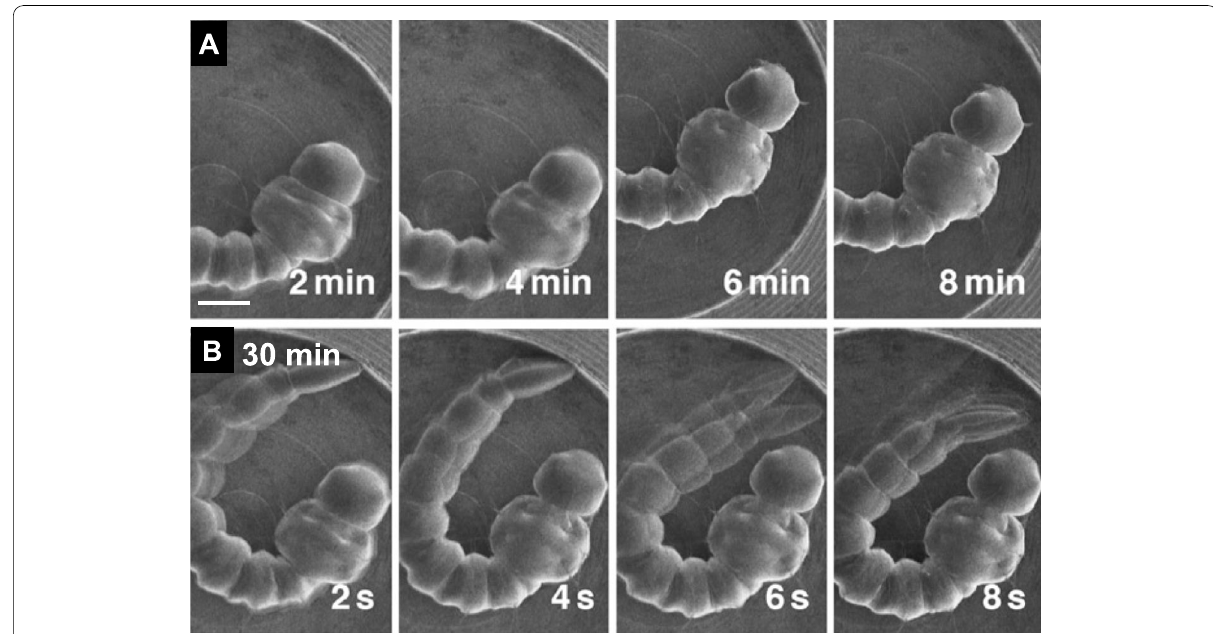
Fig. 6 Scanning electron micrographs of the larvae of the Asian tiger mosquito Aedes albopictus . A The larva immersed in 1 % Tween 20 solution for 1 min before observation. Bar 0.5 mm. B Sequential micrographs of the larva of ( A ) 30 min after observation. Blurred images in ( A ) and ( B ) = indicate active movements (Takaku et al. 2013 with permission from the